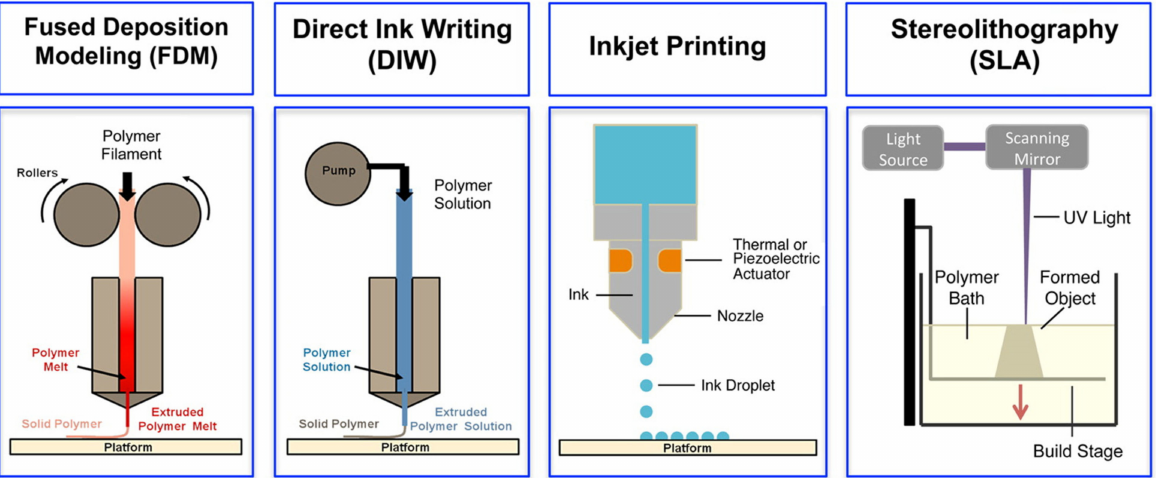
Figure 4. Schematics of different 3D printing methods: extrusion-based methods, such as fused deposition modeling (FDM) and direct ink writing (DIW), inkjet printing and light-based stereolithography (SLA). Adapted with permission from Ref. [19]. Copyright 2016, American Chemical